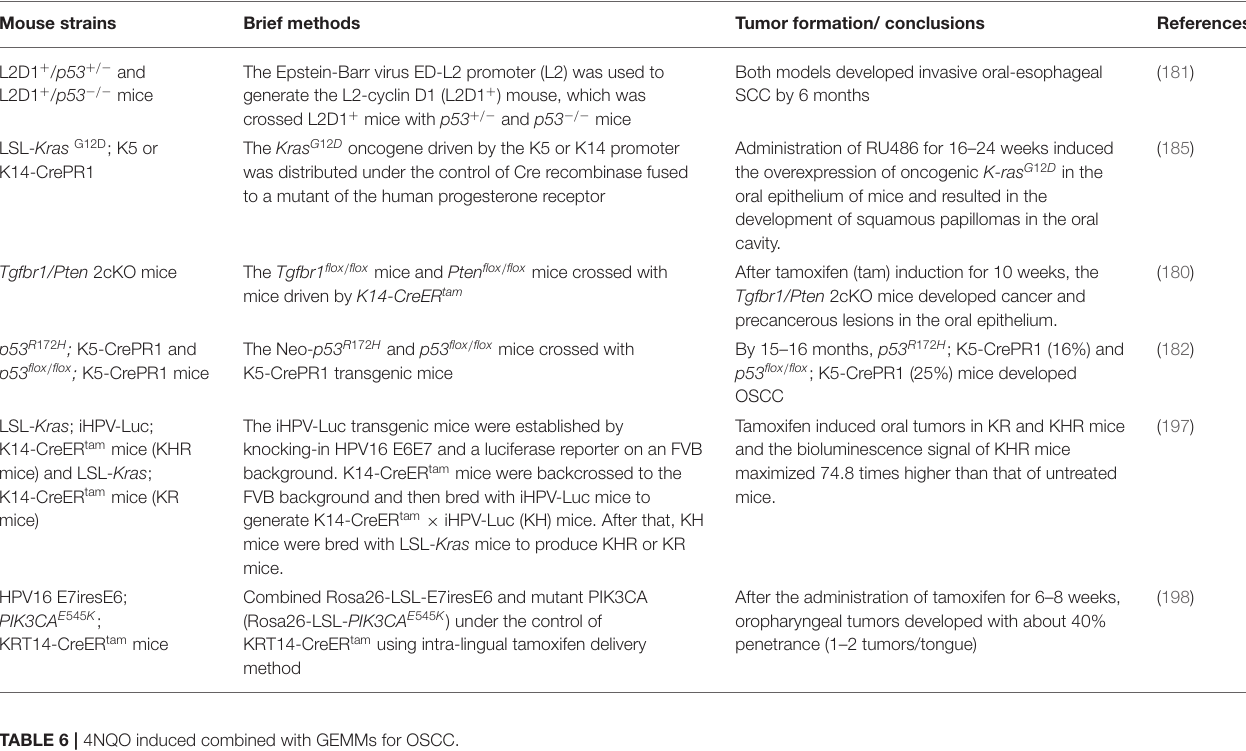
TABLE 5 | GEMMs for OSCC.